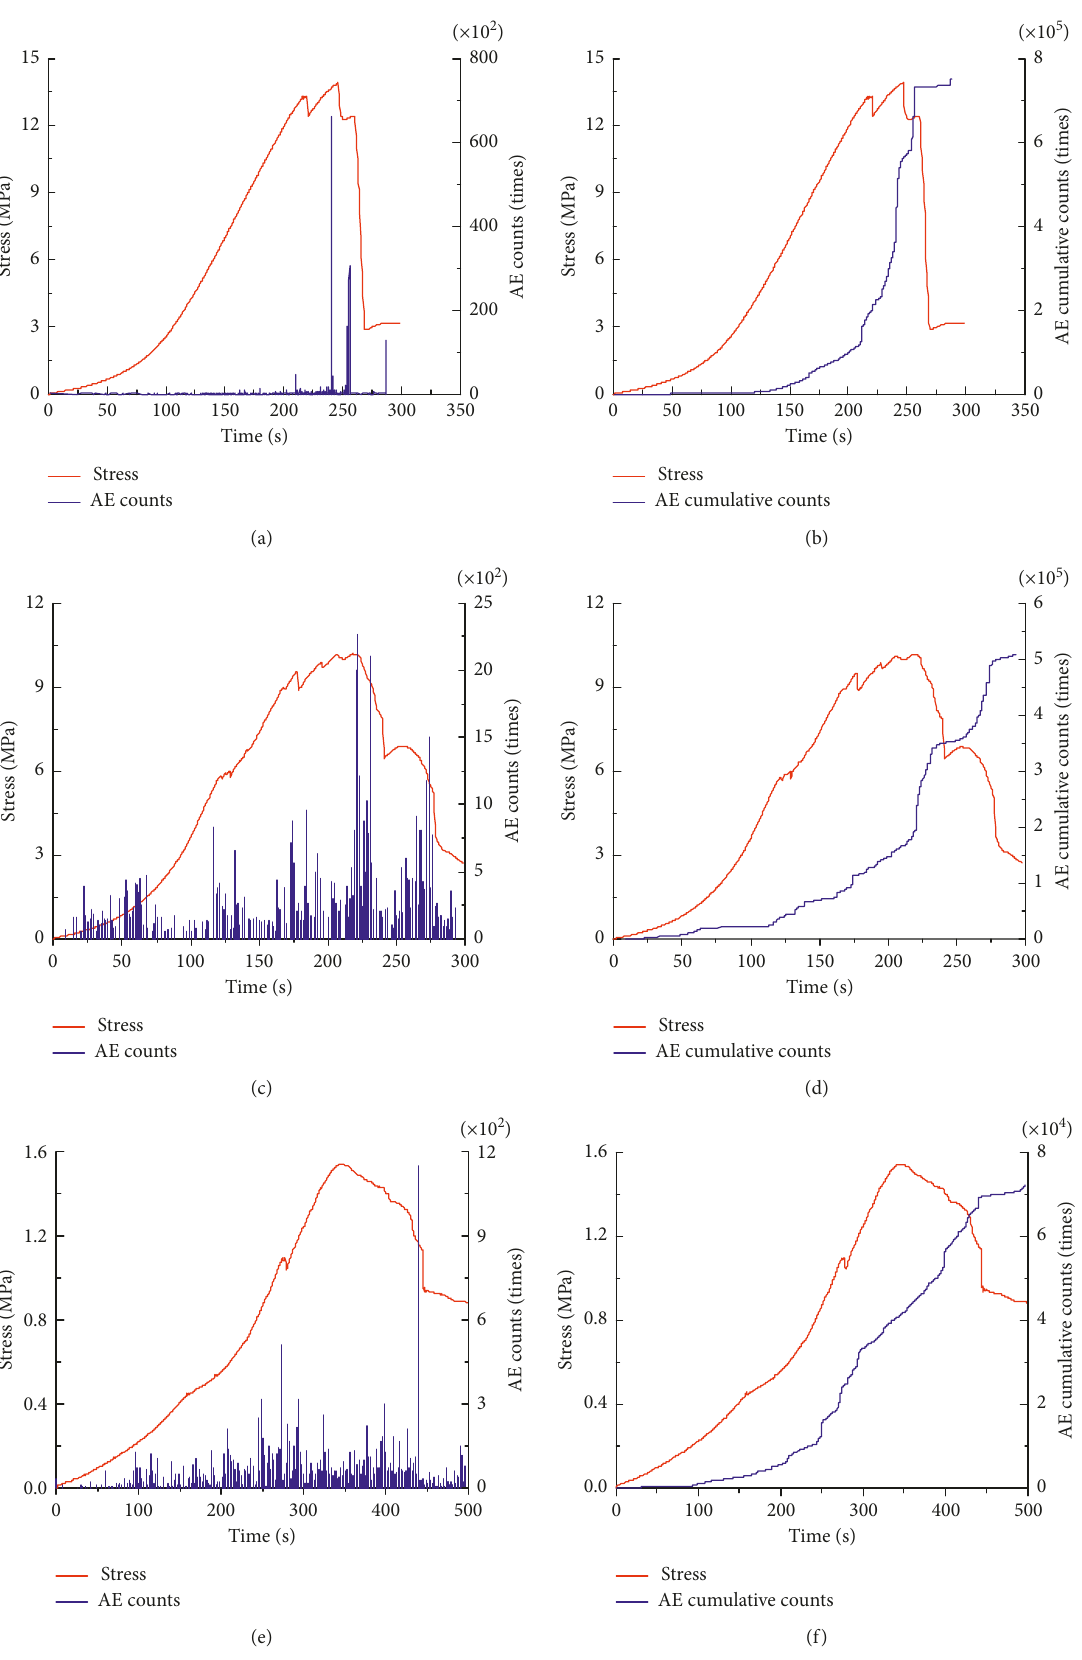
Figure 8: Variations of AE counts and cumulative counts with time of natural, naturally saturated and forcedly saturated coal samples. (a) Natural coal sample A8. (b) Natural coal sample A8. (c) Naturally coal sample B7. (d) Naturally coal sample B7. (e) Forcedly saturated coal sample C6. (f) Forcedly saturated coal sample